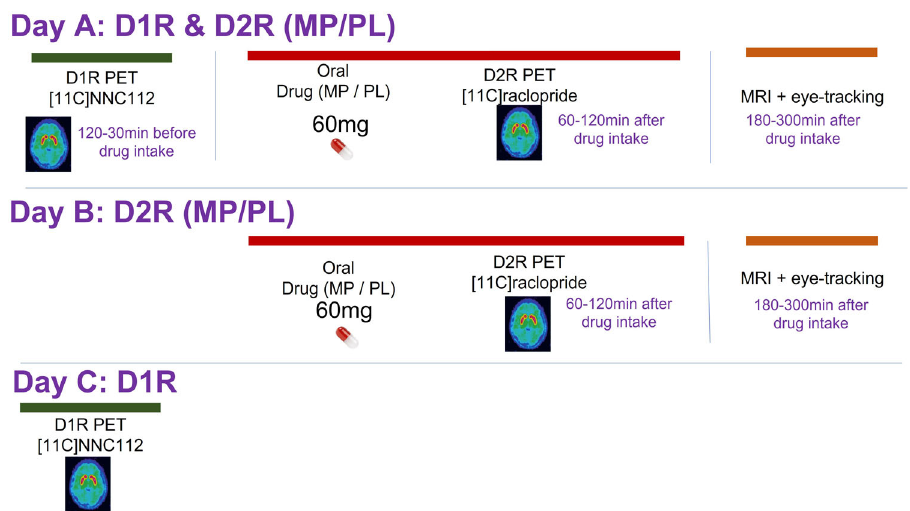
Fig. 7 Experimental design. MP: Methylphenidate, PL: Placebo, D1R PET: [11C]NNC PET scan, D2R PET: [11C]Raclopride PET scan. D1R PET scan was conducted always before or in a separate day than the D2R PET scan. Eye-tacking data was collected during the resting fMRI scan at the beginning of the MRI session, which was always 1 – 2 h after the D2R PET scan. Participants were lying on supine position in the MRI scanner during the eye-tracking recording